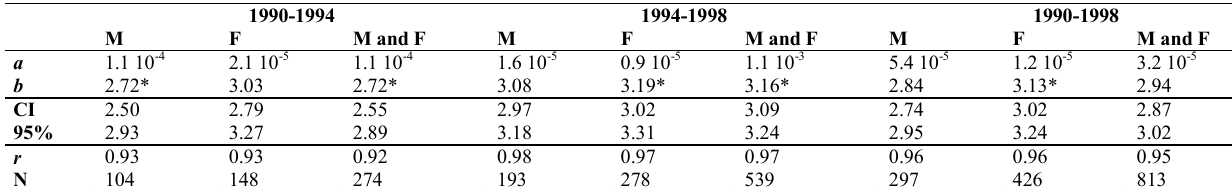
Table 3 . Length-weight relationship of L. acutidens. M = males, F = females, CI = 95% confidence interval, a and b = regression parameters, r = Pearson correlation coefficient, N = number of individuals in the sample . Asterisks denote significant differ- ences of coefficient b from 3 according to a one-sample, two-tailed t -test (see text for details).